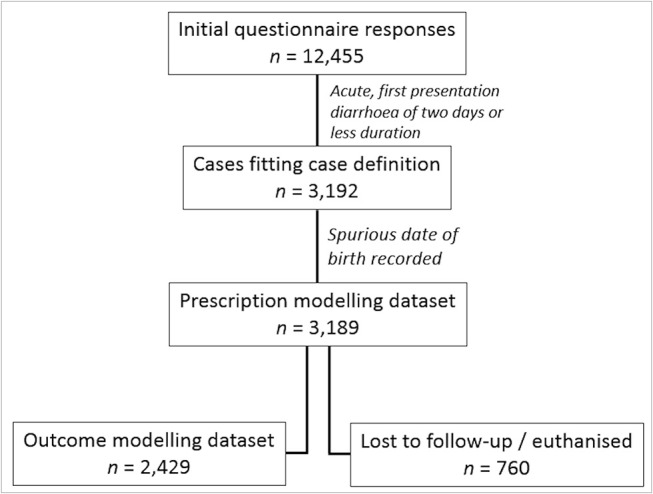
Flow diagram showing case selection procedure for prescription modelling, loss to follow-up, and outcome modelling.